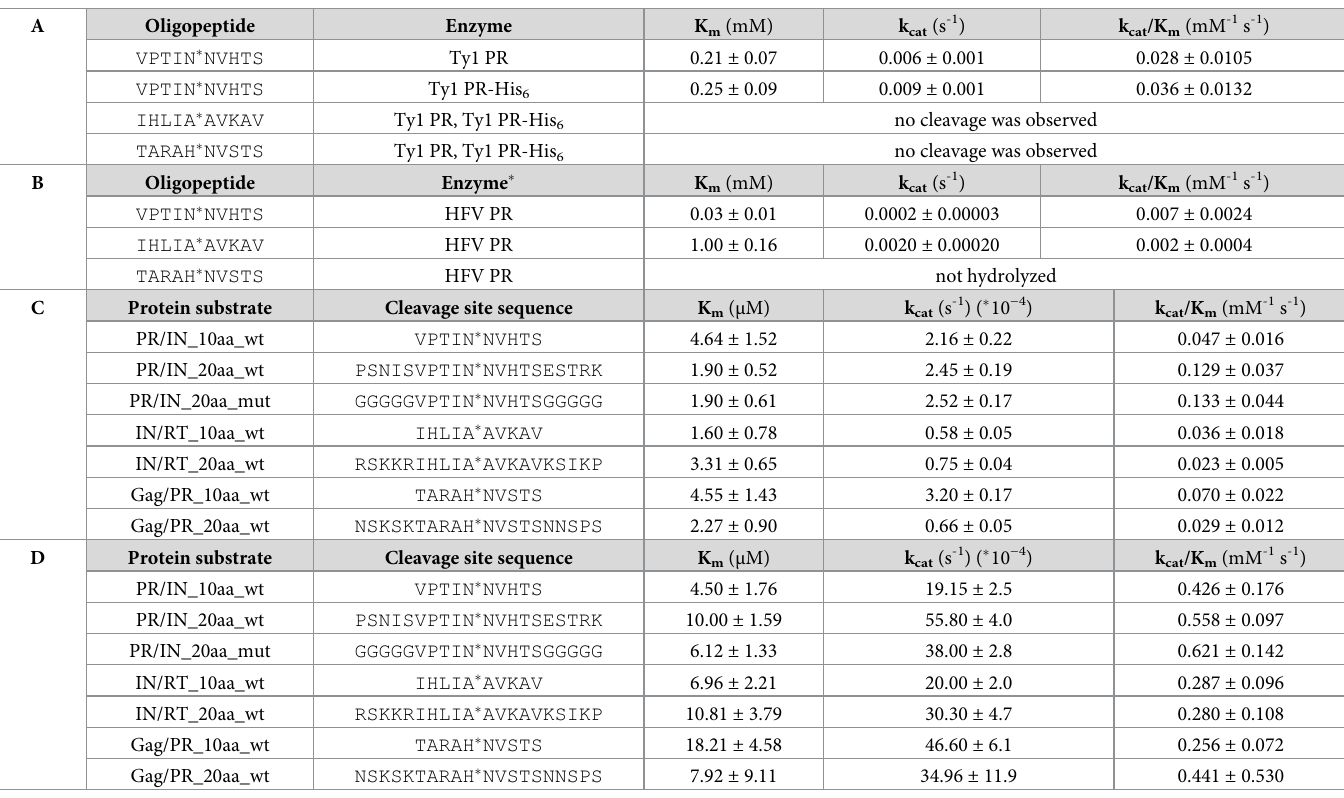
Table 1. Kinetic parameters of Ty1